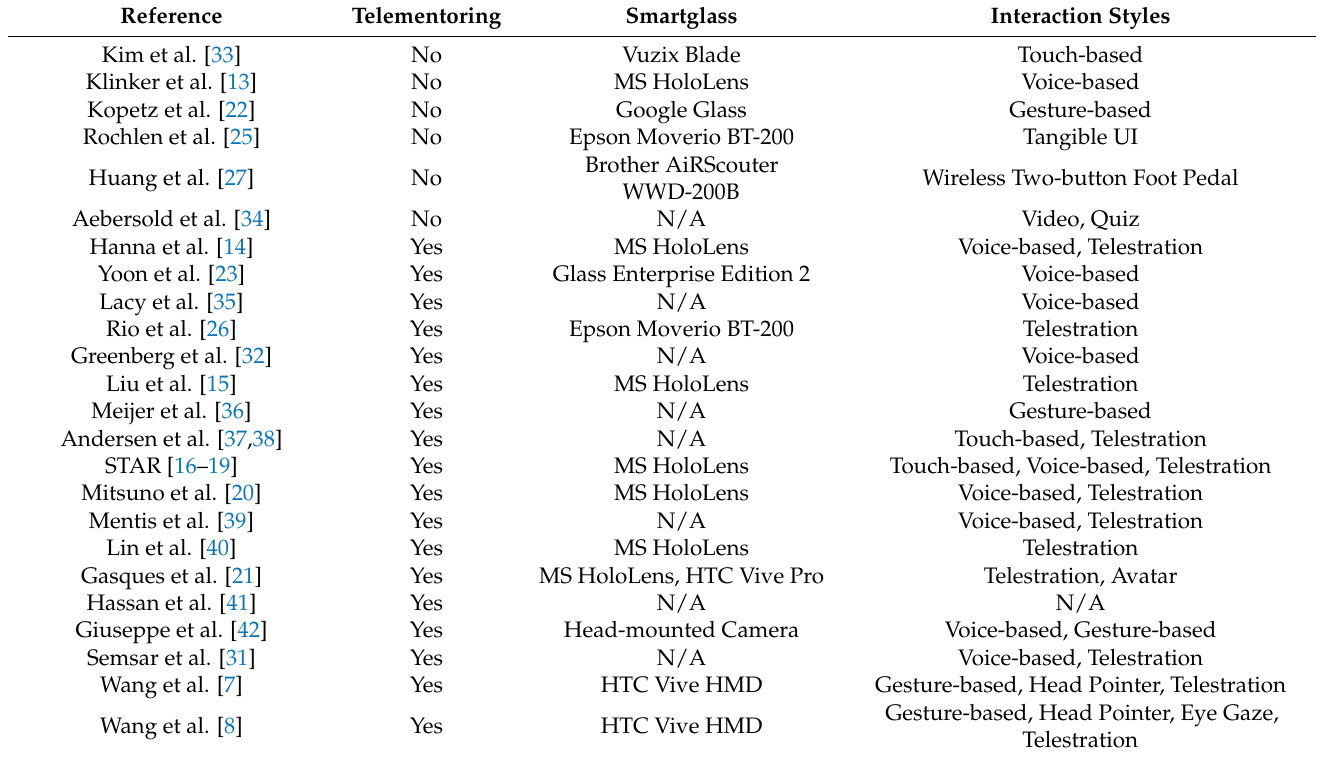
Table 2. Telementoring Studies with Smartglasses and Interaction